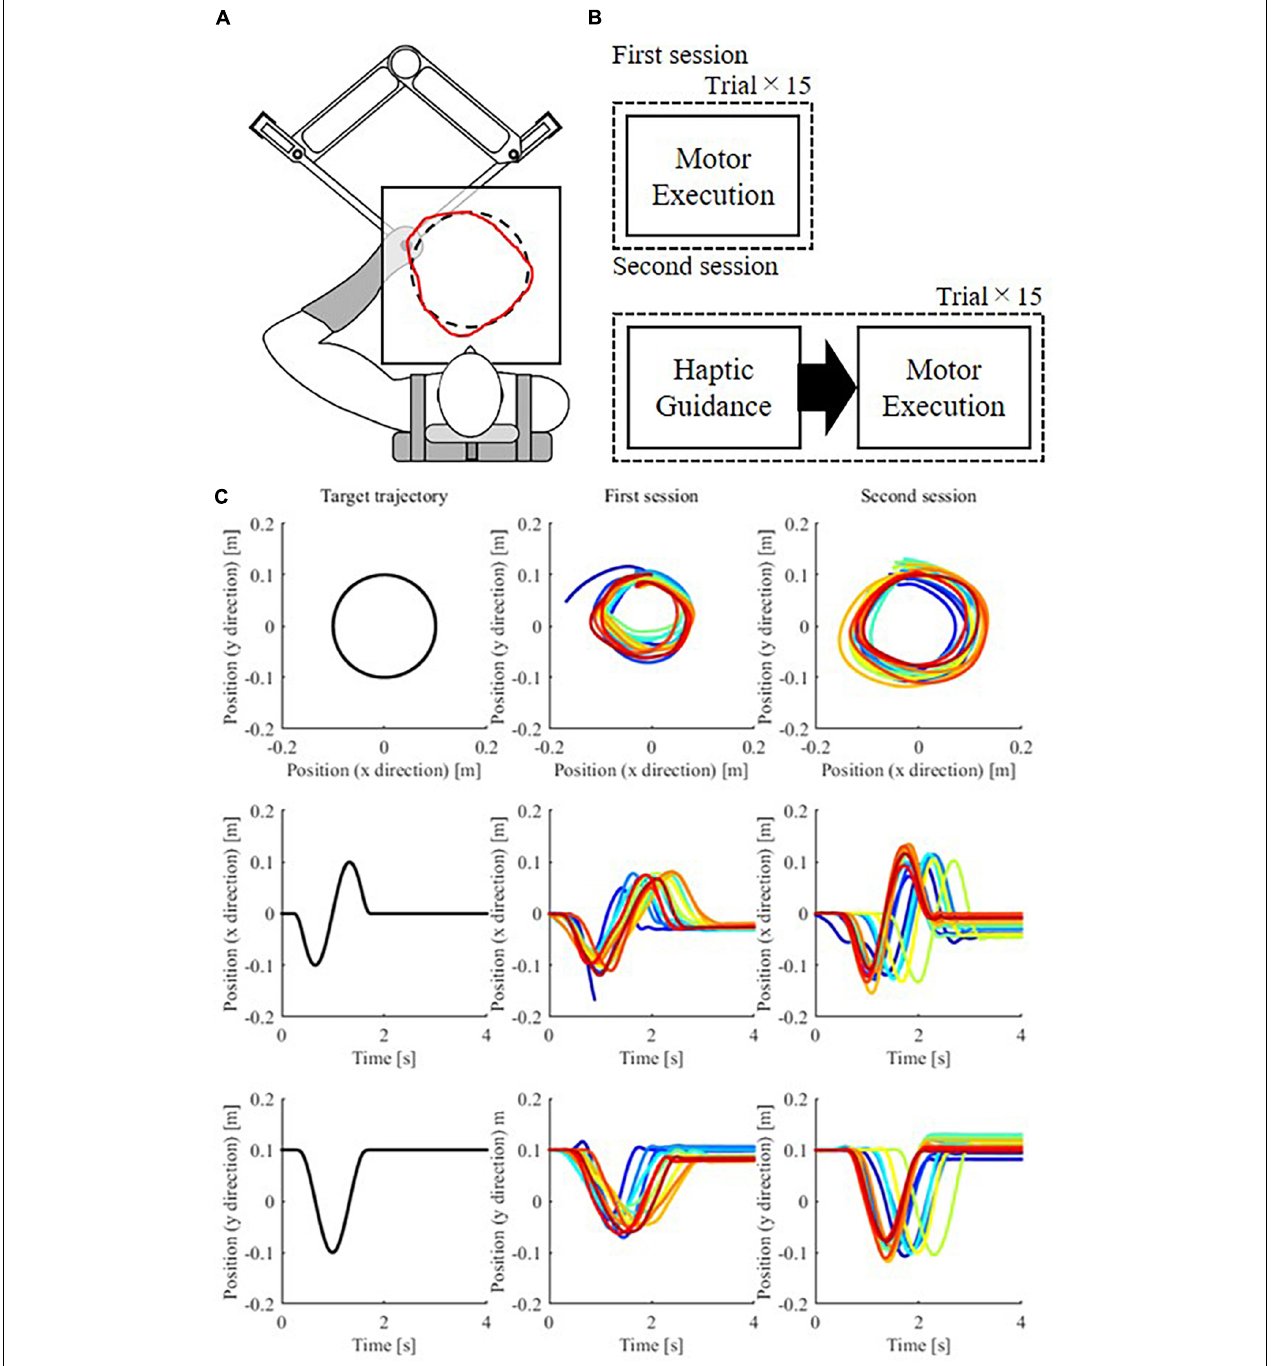
FIGURE 2 | (A) Motor task and apparatus. Participants were asked to draw a true circle (dashed line) using their left hand within 2 s. A manipulandum located under the table provided haptic guidance. The participants could hold a handle on the manipulandum, and it moved to guide their hand in the desired direction. The red line shows a representative example of a handwritten trajectory. Both the target circle and drawn figures were hidden from the participants during motor execution, such that the participants never saw the actual hand position. (B) Procedure. The participants completed 15 trials in which they drew a circle with score feedback at the end of each trial. Next, the participants completed 15 trials in which they first received haptic guidance from the robot, that is, allowed the robot to move their hand in the desired trajectory, and then executed the drawing movement by themselves without being assisted by the robot. Finally, they received their score at the end of each trial. (C) Target movement and executed movements by a participant at both sessions in the x–y plane and its time trajectory in the x and y directions. Early trials are plotted as blue traces, and subsequent trials are denoted by “warmer” colors.